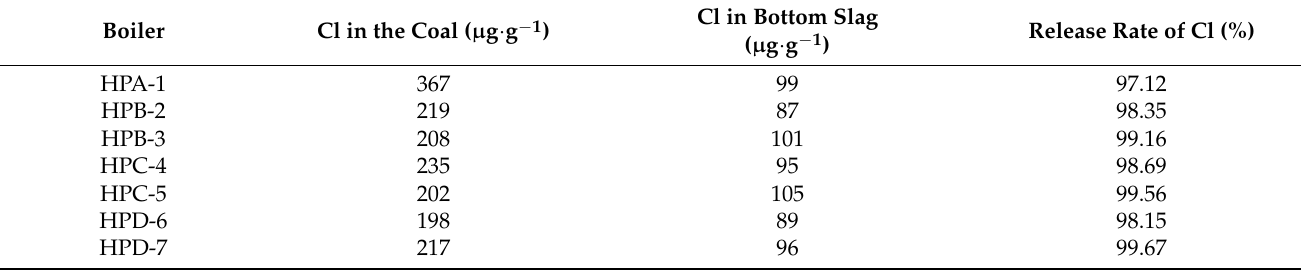
Table 6. The release rate of Cl in